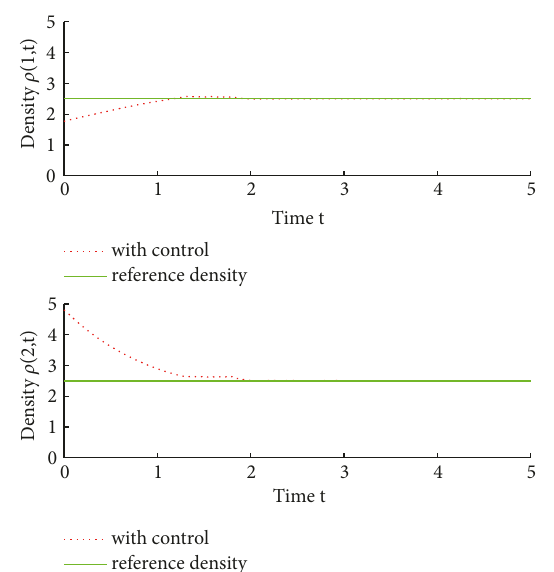
Figure 5: Density evolution at 𝑥 = 1 and 𝑥 = 2 with Constant Reference 𝑅 𝑐 = 2.5 .